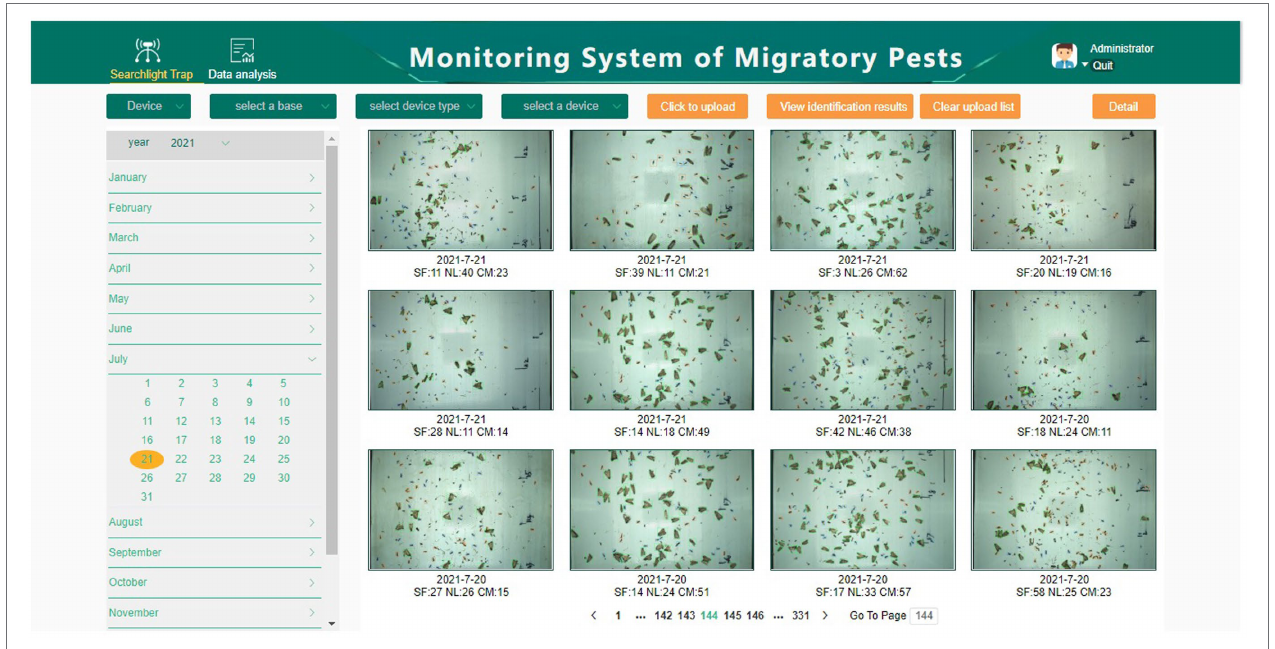
FIGURE 7 | Web client interface of intelligent monitoring system of migratory